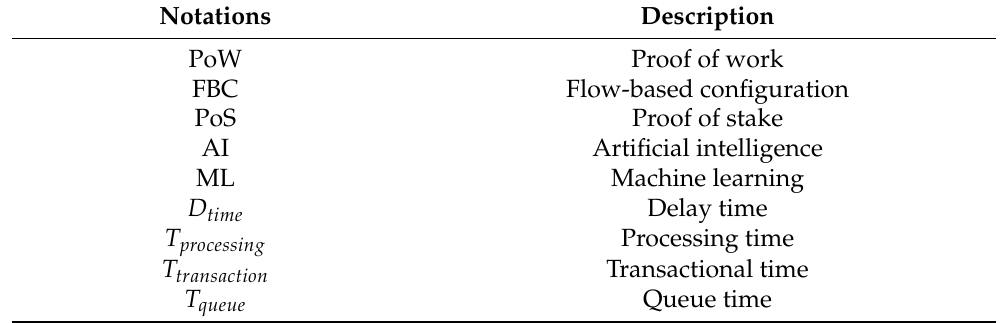
Table 4. Notations.